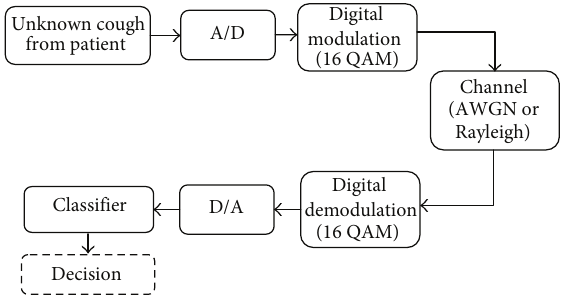
Figure 6: Block diagram of simulation